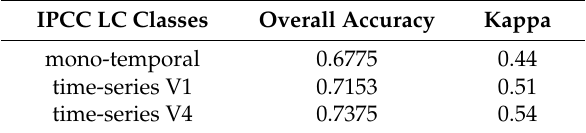
Table 4. Accuracies of mono-temporal versus time series approach for IPCC LC classes.